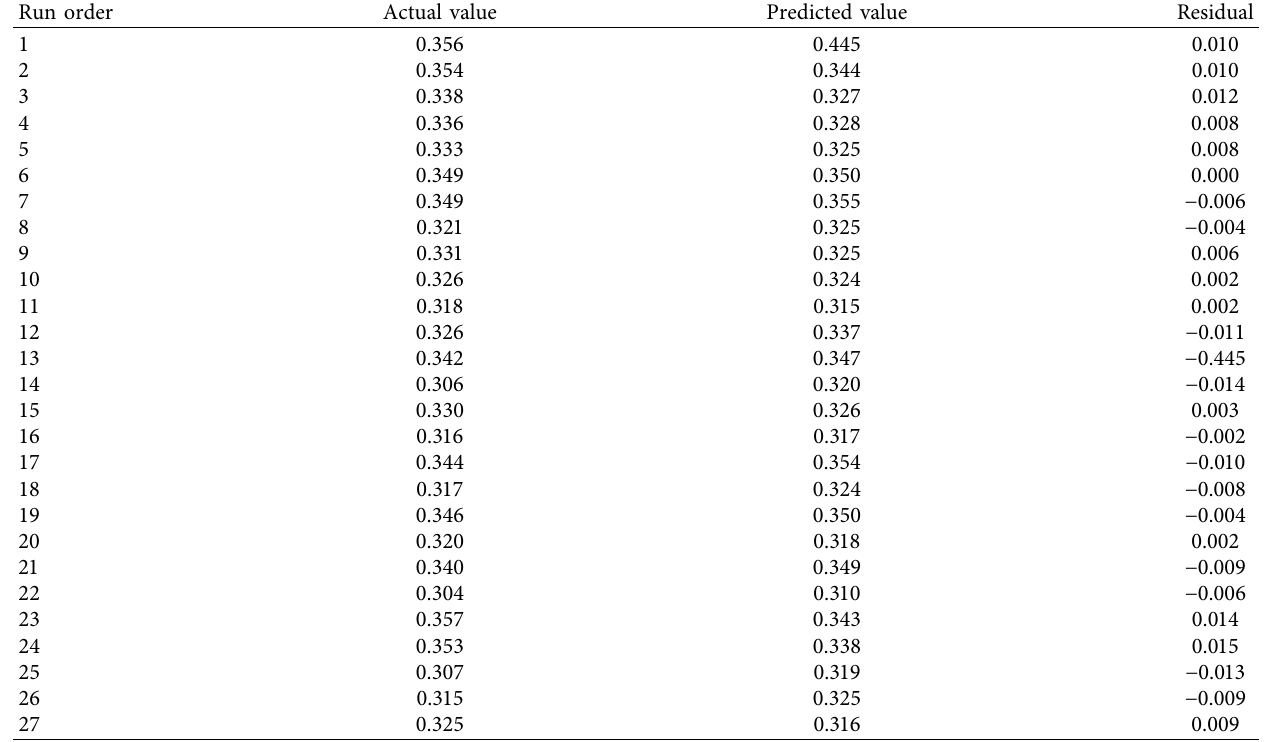
Table 5: Optimization results of kerf width.